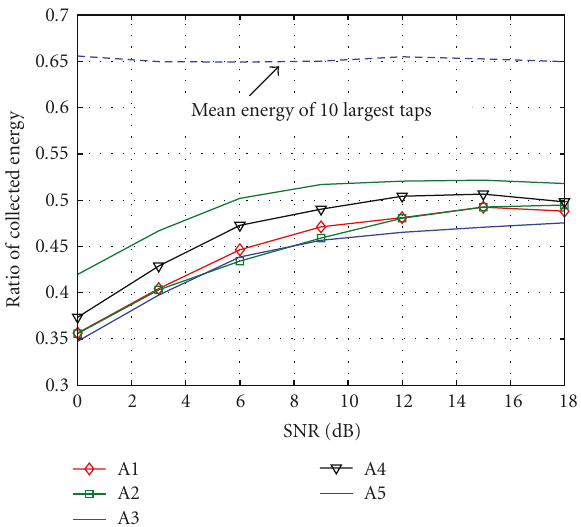
Figure 6: The mean ratio of the collected energy by A1–A5, corresponding to the results in Figure